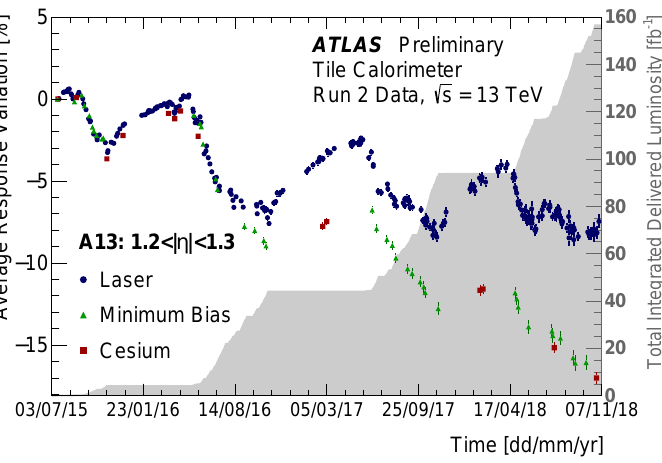
Figure 4. The variation of the average response to cesium, laser and minimum bias for the cell A13, as a function of time during the entire Run-2period